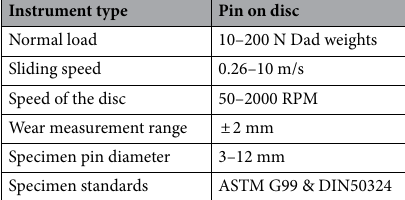
Table 3. Properties of pin-on-disc